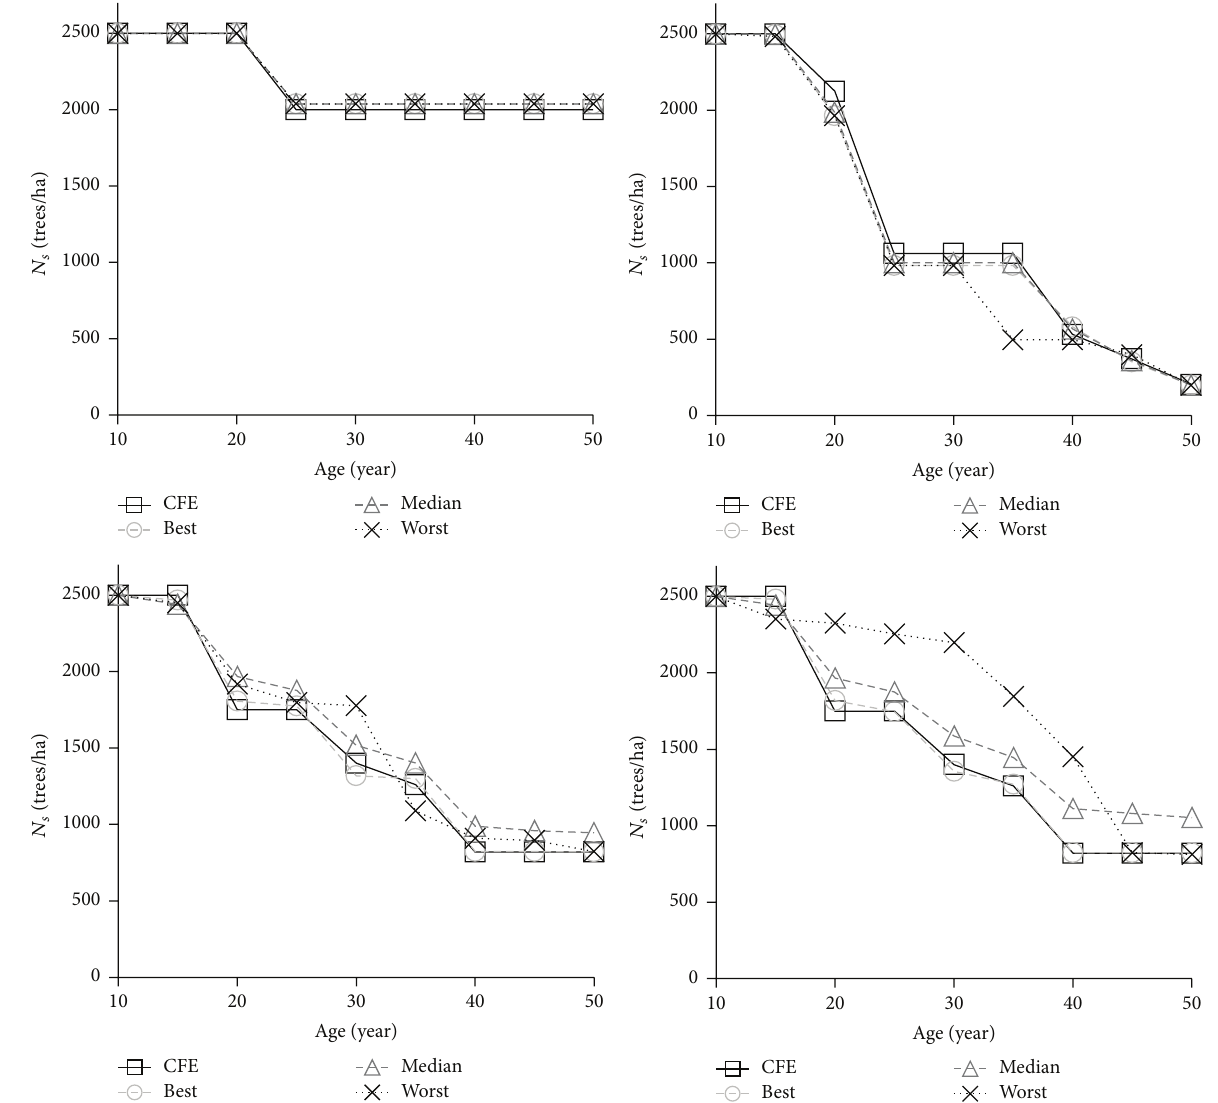
Figure 6: Trajectories of 𝑁 𝑠 produced by SA and CFE (upper: S; lower: L; left: H; right: